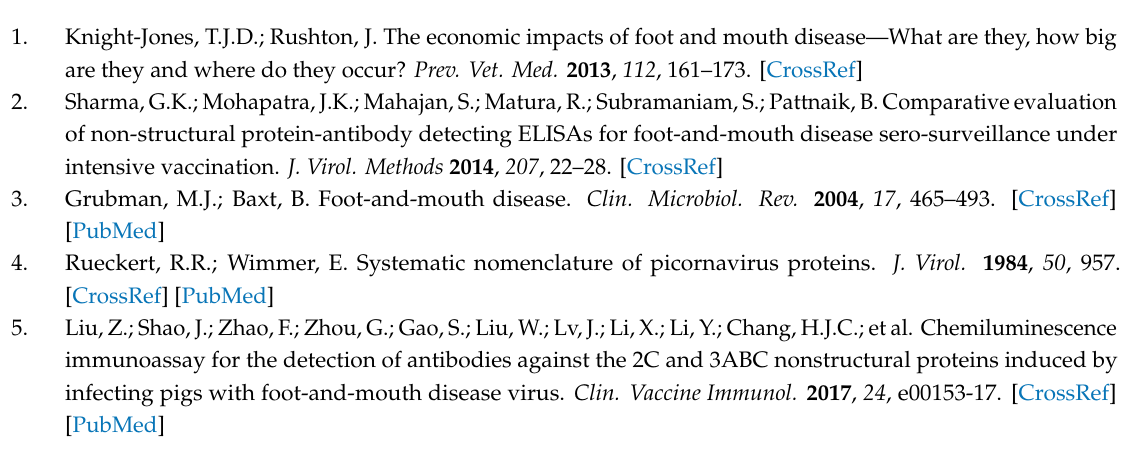
Figure S1: Antibody responses elicited by immunizations with chloroform treated and heparin a ffi nity column purified serotype O foot-and-mouth disease (FMD) Boeun / SKR / 2017